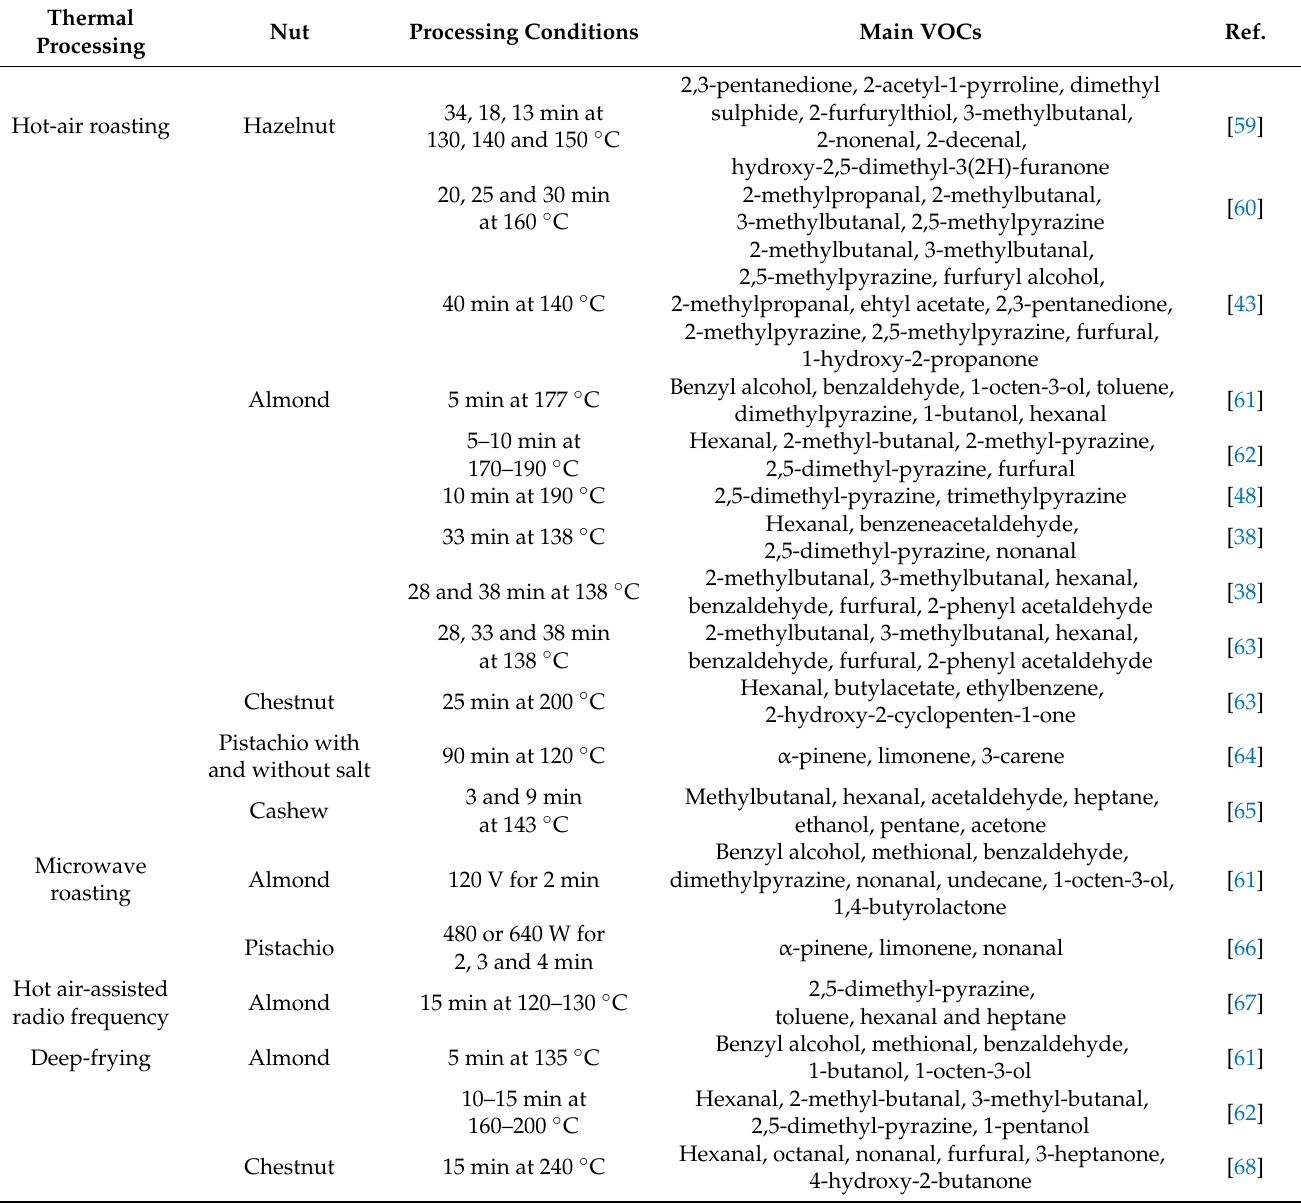
Table 3. Most popular thermal processing methods of nuts and main VOCs reported in the